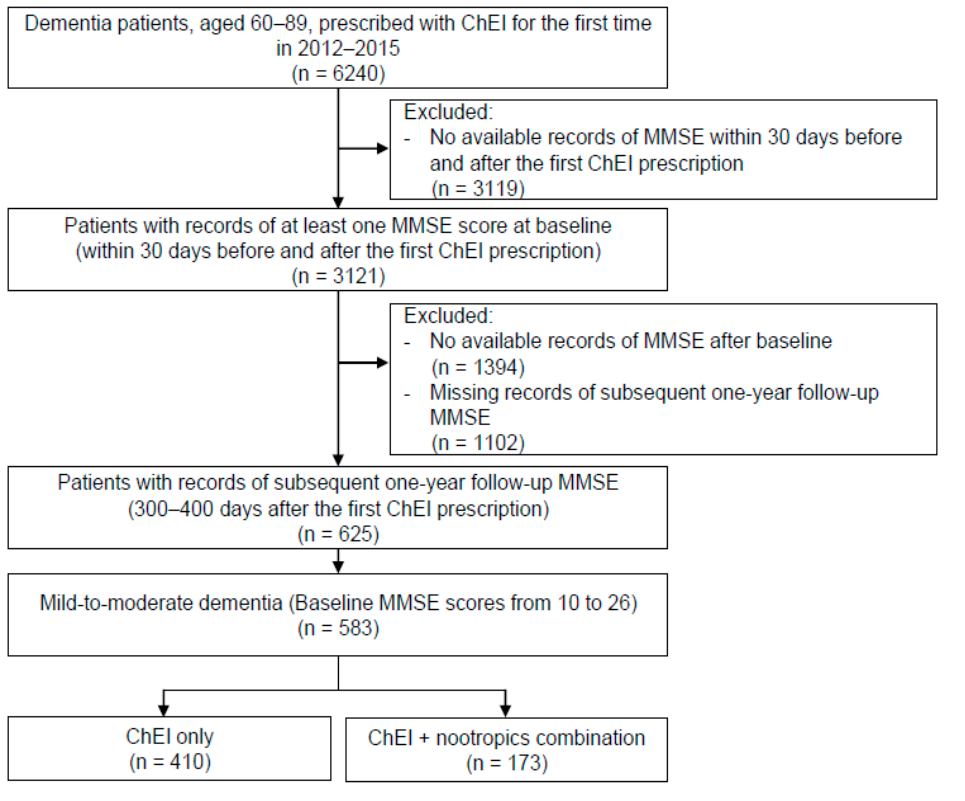
Figure 1. Flow diagram of study sample selection. ChEI: cholinesterase inhibitor; MMSE: mini-mental state examination.